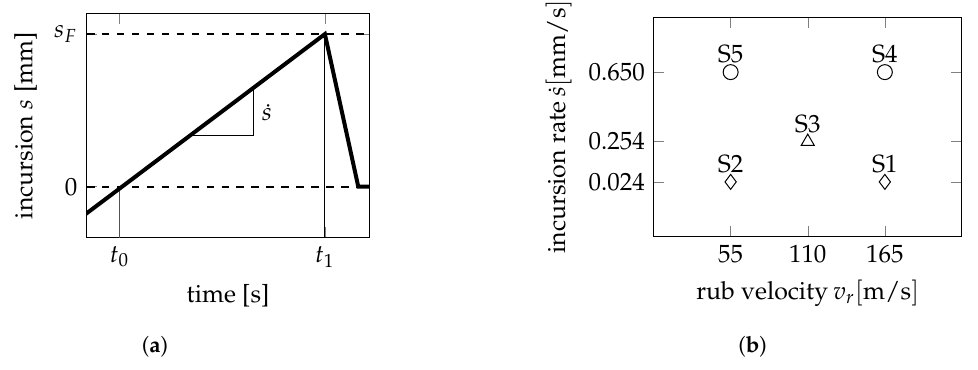
Figure 3. ( a ) Typical incursion profile; ( b ) test matrix for all five rub scenarios (S1–S5) with varying incursion rate ˙ s and rub velocity v r , modified according to [18].